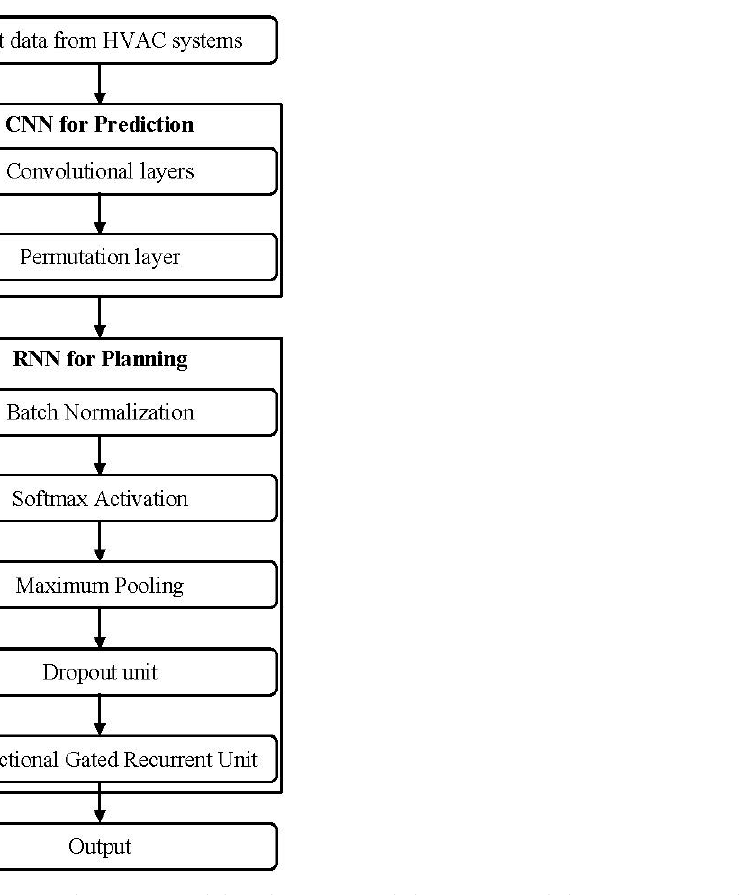
Figure 2. Deep learning model with automated detection module. CNN: Convolutional Neural Network and RNN: Recurrent Neural Network.